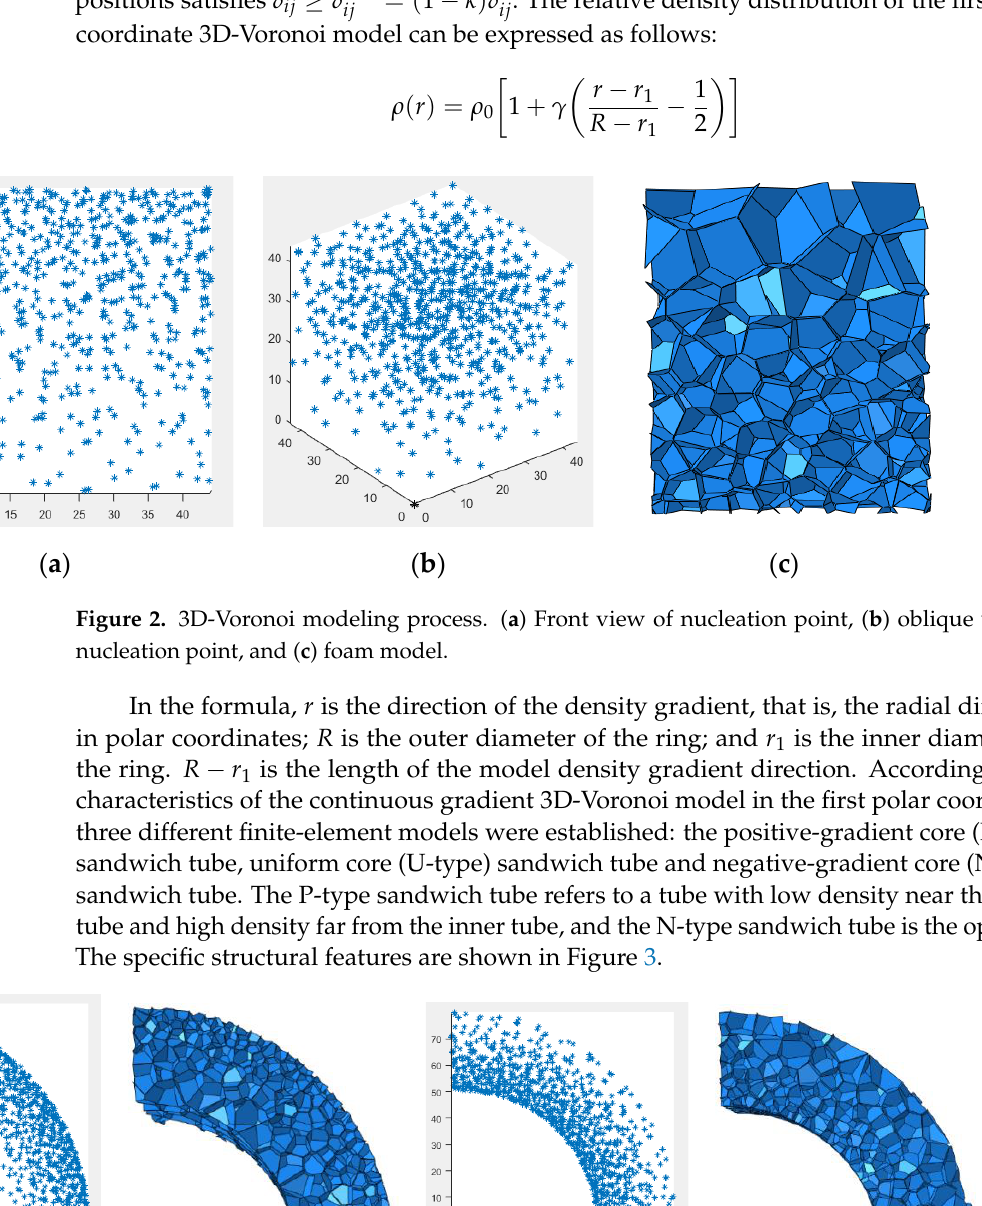
Figure 2. 3D-Voronoi modeling process. ( a ) Front view of nucleation point, ( b ) oblique view of nucleation point, and ( c ) foam model.